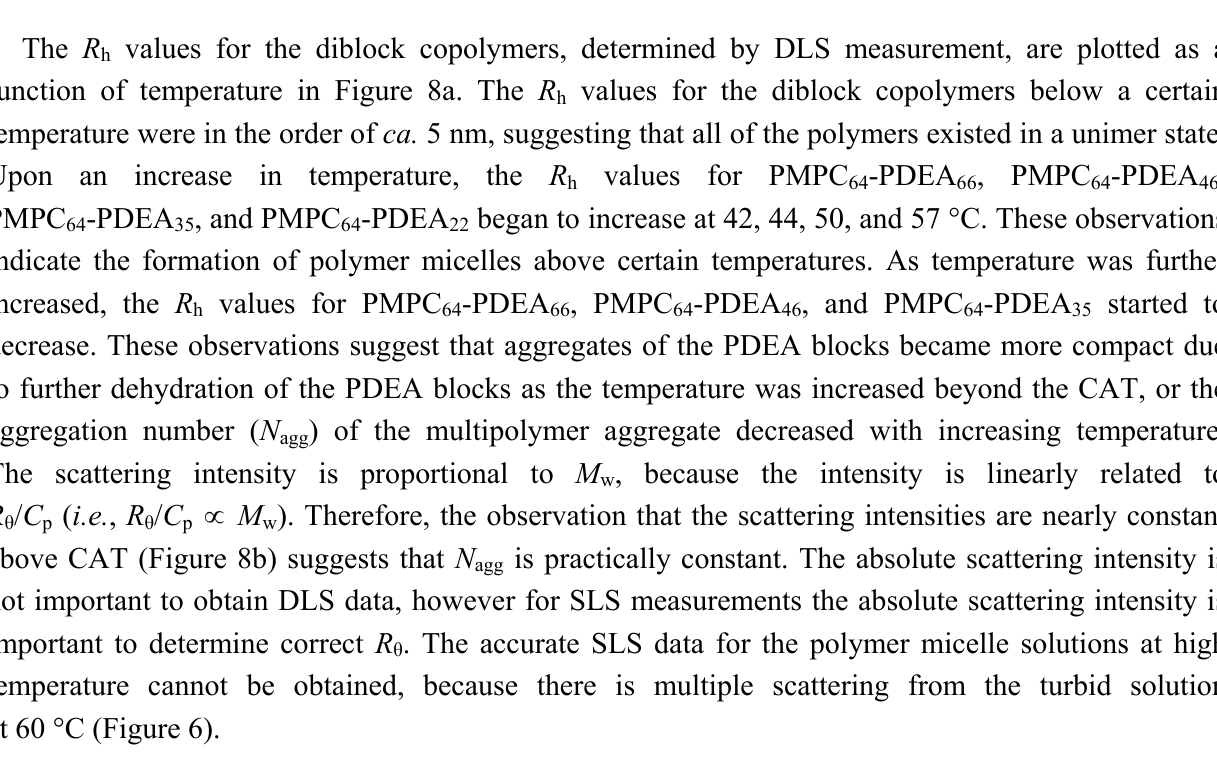
) and ( b ) scattering intensity for PMPC h -PDEA ( ◇ ), and PMPC 64 35